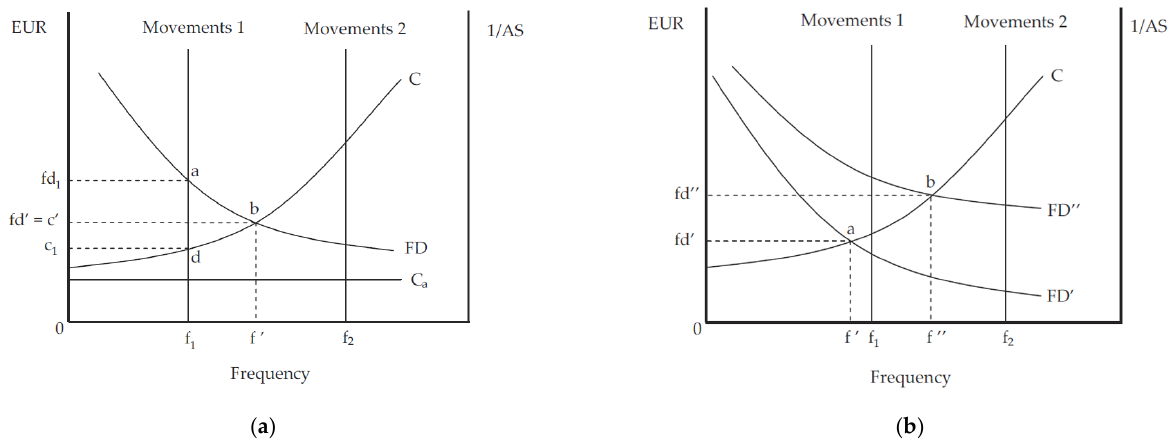
Figure 12. Benefits and costs in airside capacity provision [11]; ( a ) effect of an increase in capacity (Movements 1 → Movements 2); ( b ) effect of an increase in income on the investment case for airside infrastructure.